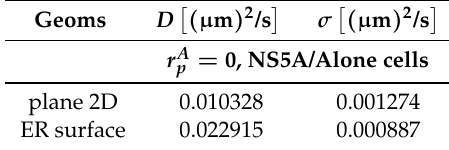
Table A3. Averaged final NS5A diffusion constant D A ns5a (for the NS5A/Alone cell case) as